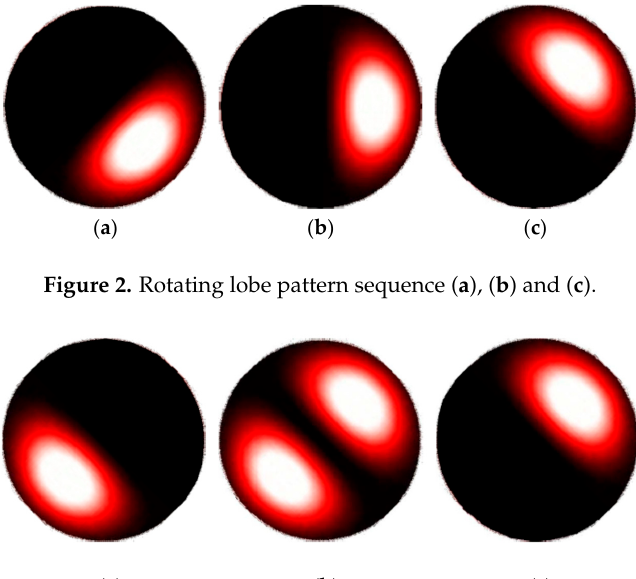
Figure 3. Pulsating lobe pattern sequence ( a ), ( b ) and ( c ).